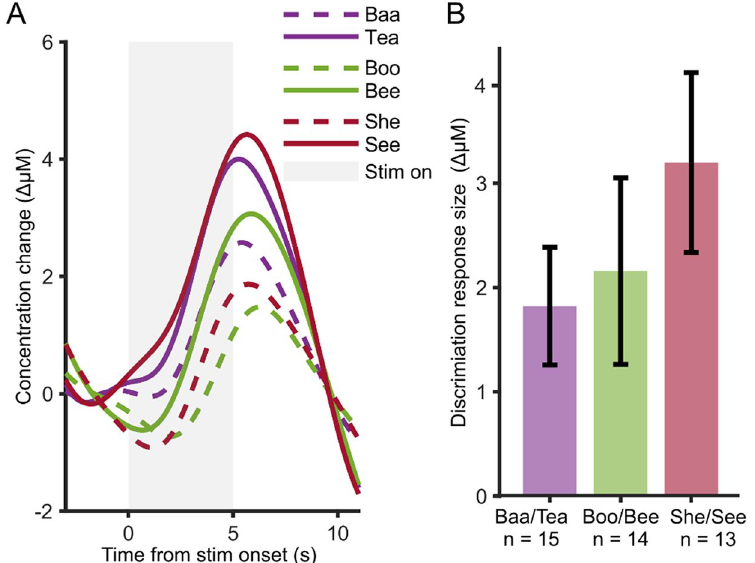
Figure 7. Difference between “Novel” and “Hab 2” conditions for each speech token contrast pair. ( A ) Shows the group average responses for each speech token (one color each); the “Hab 2”and “Novel" responses are represented by the broken and solid traces respectively. ( B ) Shows the calculated response size difference as a bar graph; error bars are one standard error of the mean across participants. Labels on x-axis indicates the number of participants who were delivered that particular speech token pair stimuli. There is no significant difference between discrimination response